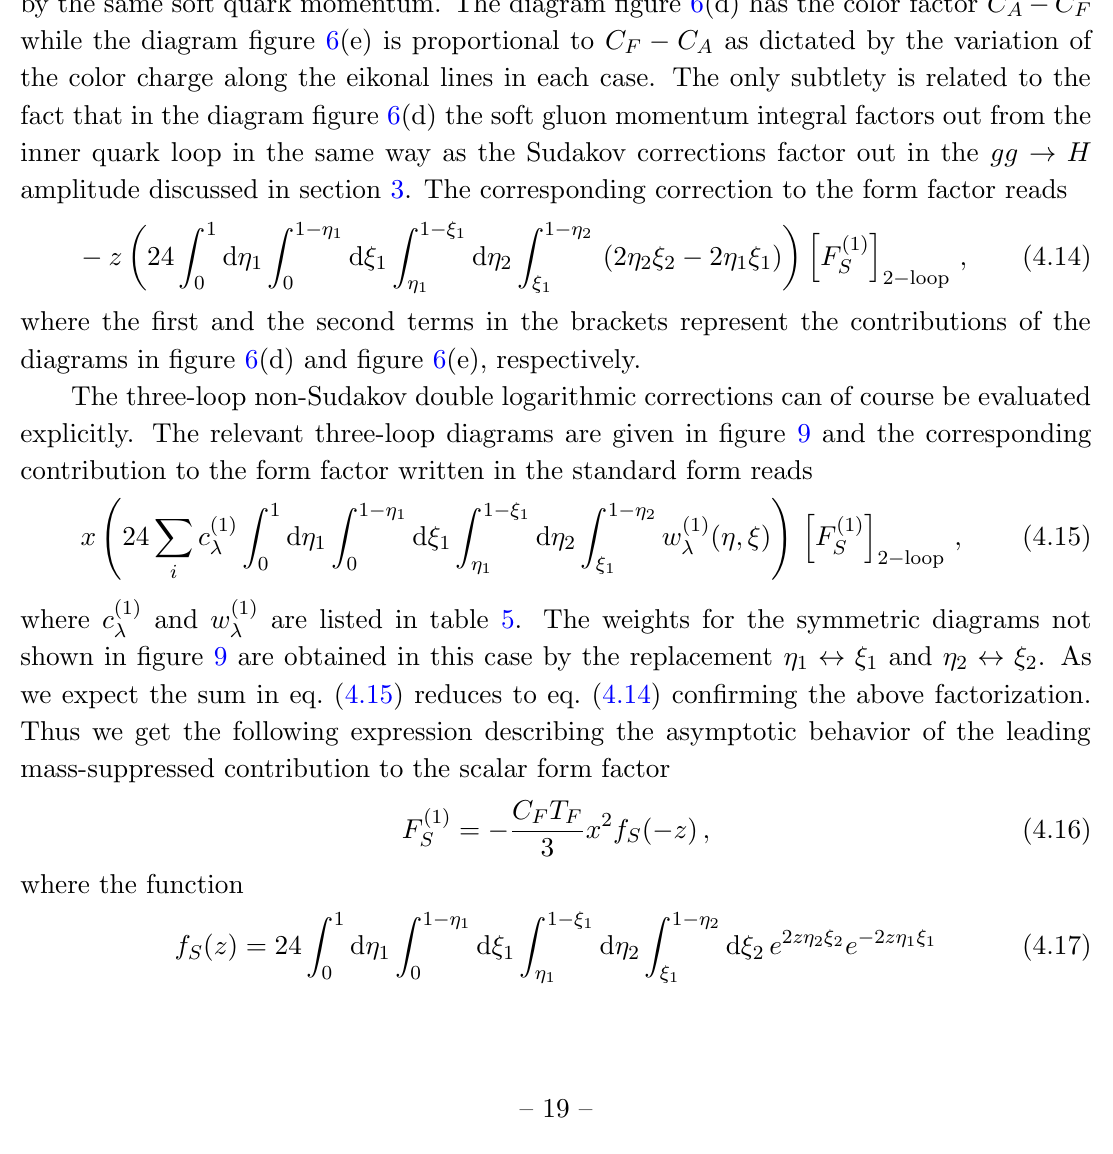
Figure 9 . The three-loop diagrams contributing to the scalar form factor F (1) diagrams and the diagrams with the opposite direction of the closed quark line are not shown. The remaining diagrams either do not have the double-logarithmic integration region or have vanishing color